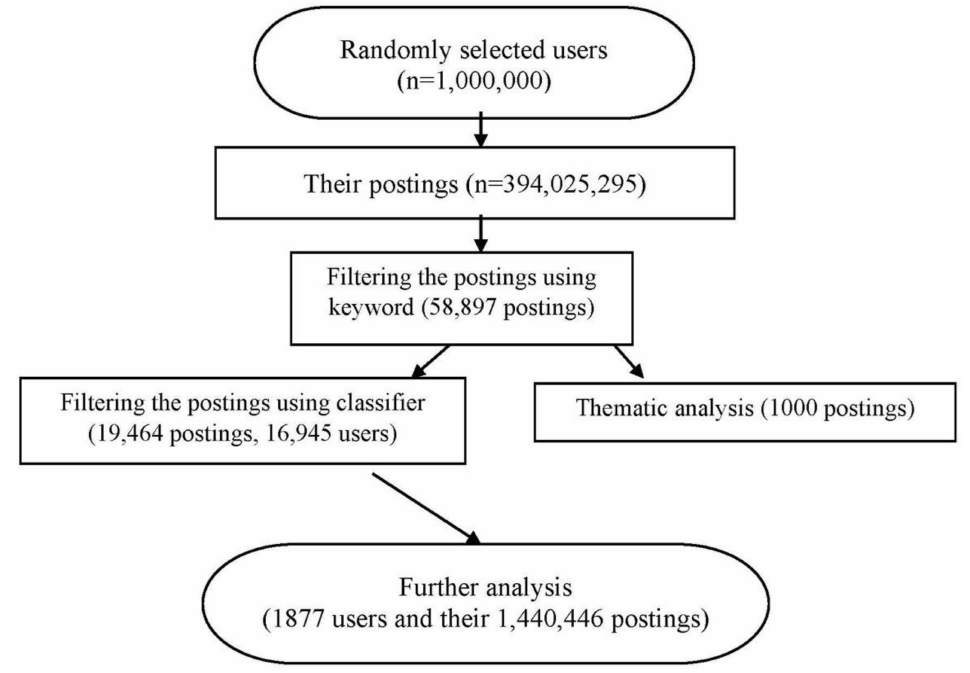
Figure 1. Flowchart of procedure for selecting postings related to